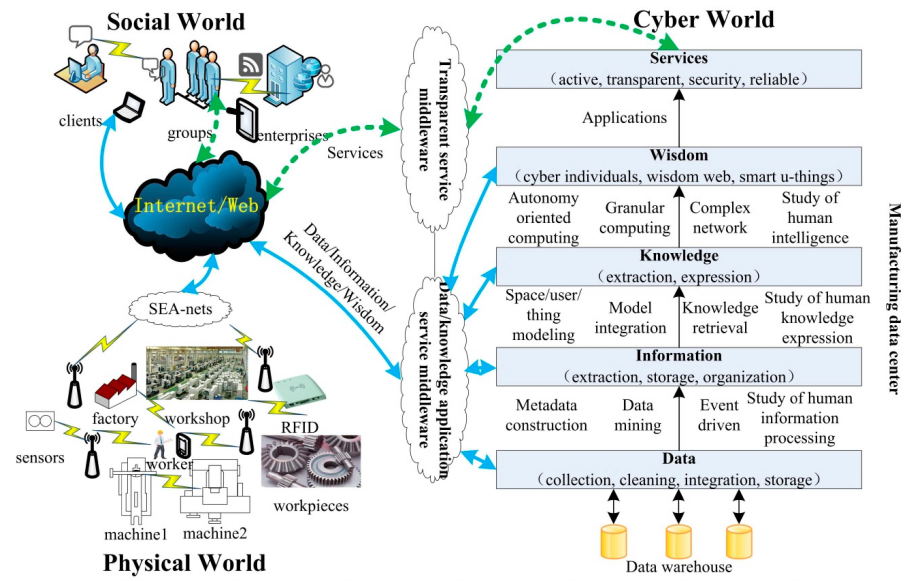
Figure 1. Wisdom manufacturing model based on SCPS